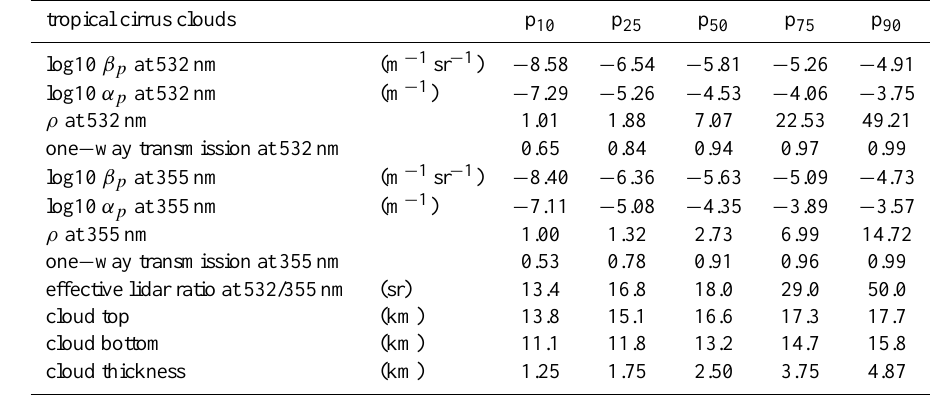
Table 1. Tropical cirrus cloud statistics for the winter (January 2007) period. Statistics are given by percentiles p i with i denoting the percentage of data with values smaller than the table value. β p and α p denote ice cloud particle backscatter and extinction respectively, ρ is the scattering